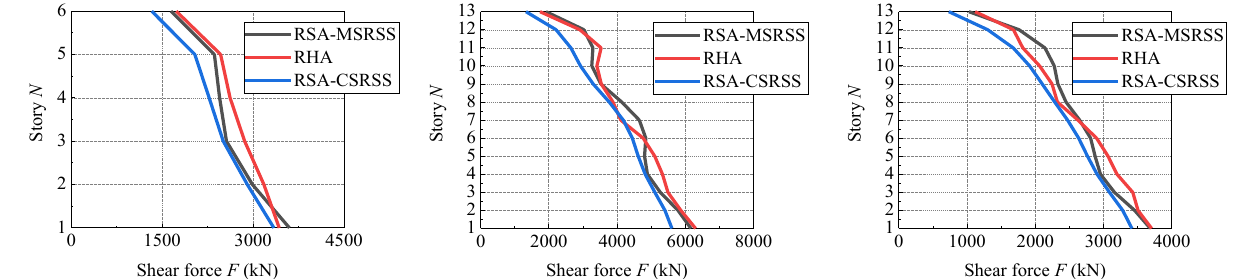
Figure 13. Shear force demands of the two demonstration buildings under typical ground motion. Table 2. Deviation of the results between RSA and RHA.